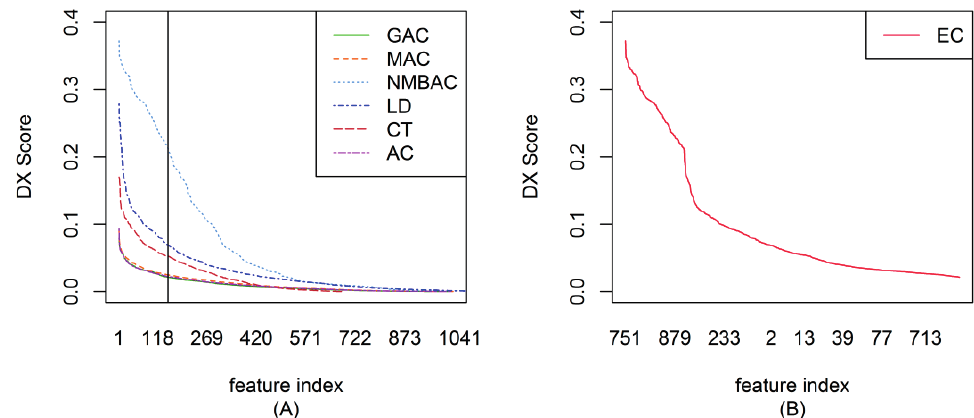
Figure 3. DX score distribution of the different coding methods on the Gold Human dataset. ( A ) The result of six methods; ( B ) The result of EC